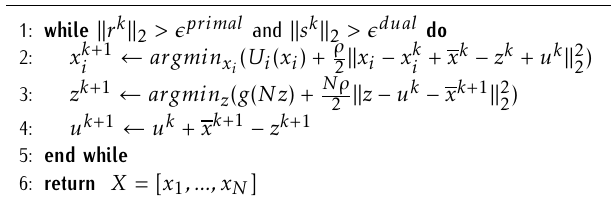
Algorithm 1. The variable x is the mean of all x i : (cid:80) N x = 1 x i . i =1 N Algorithm 1 ADMM